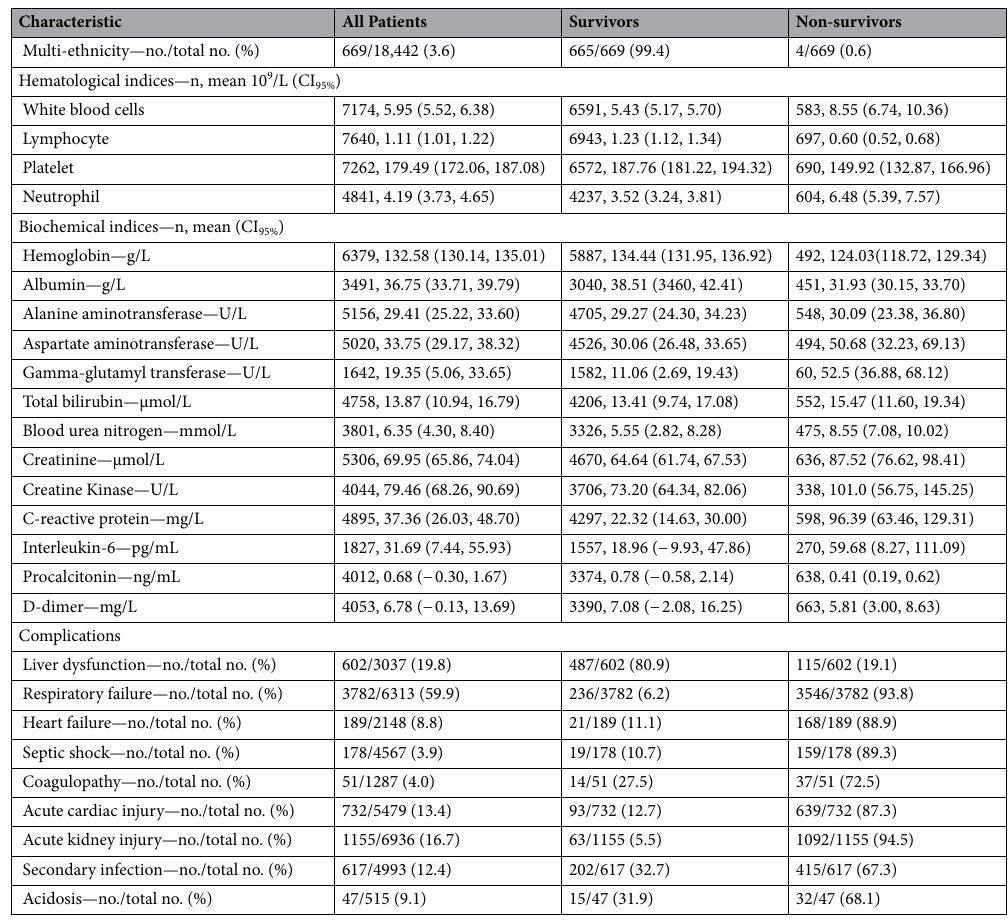
Table 1. COVID-19 patient characteristics, blood parameters, pre-existing conditions, and complications